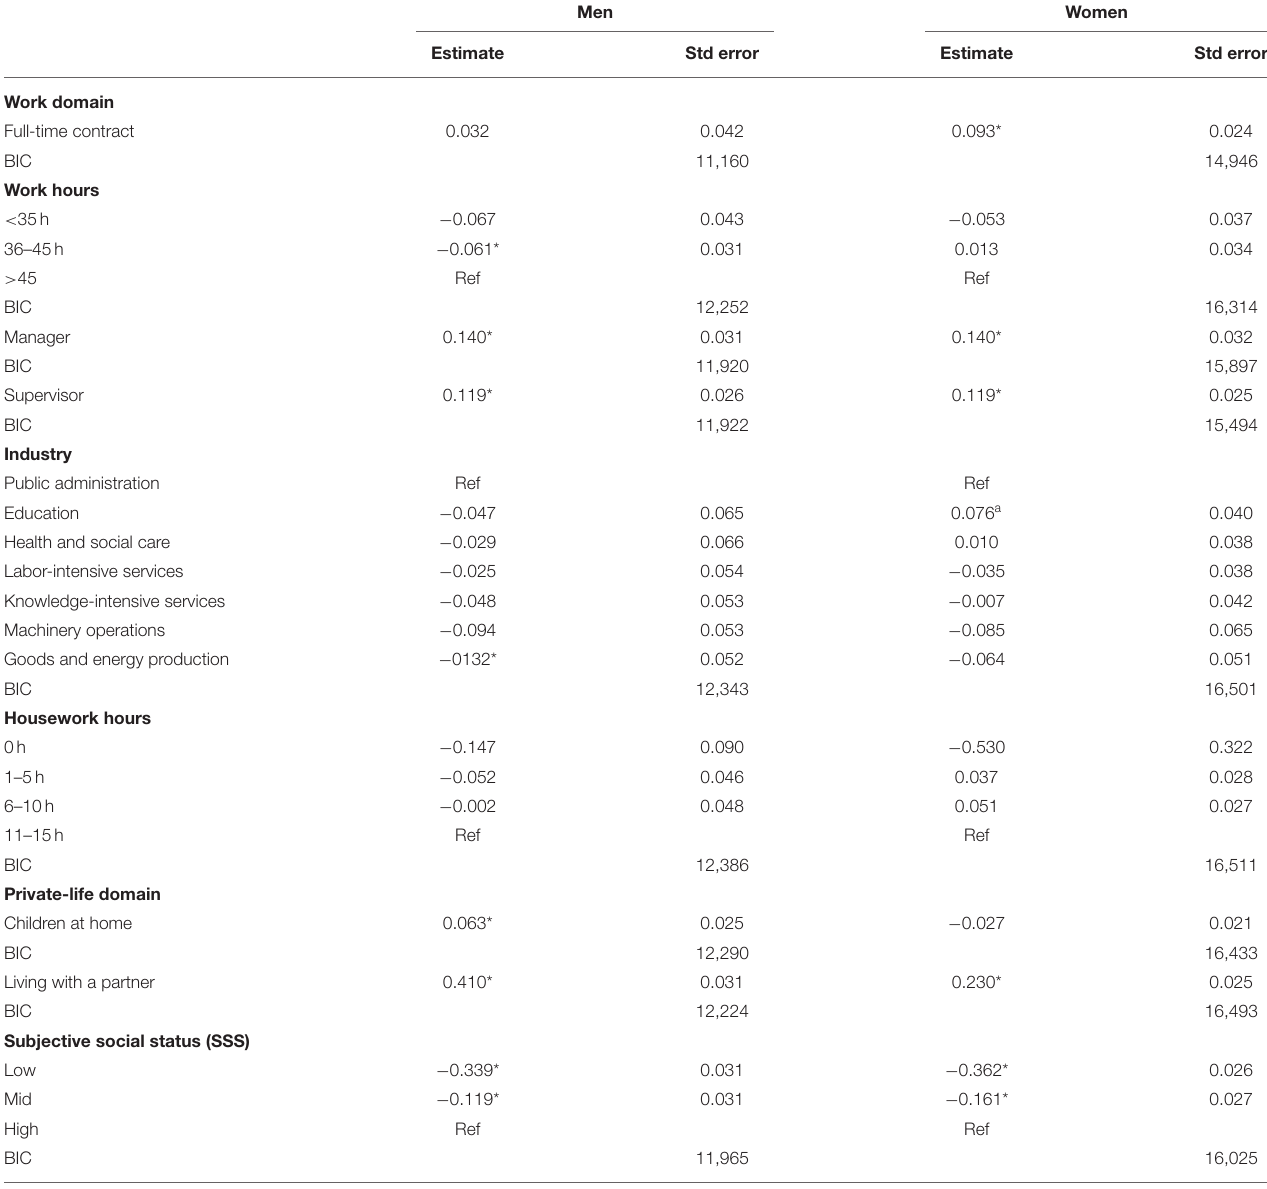
TABLE 2 | Linear mixed model for men and women separately for the likelihood of reporting life-work enrichment